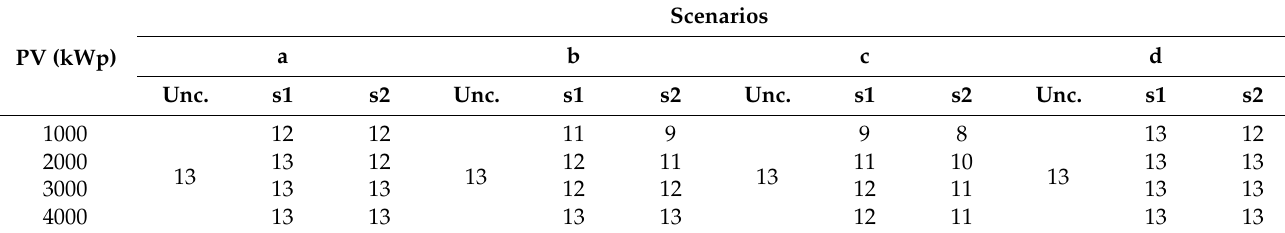
Table 5. Payback period estimated in years.